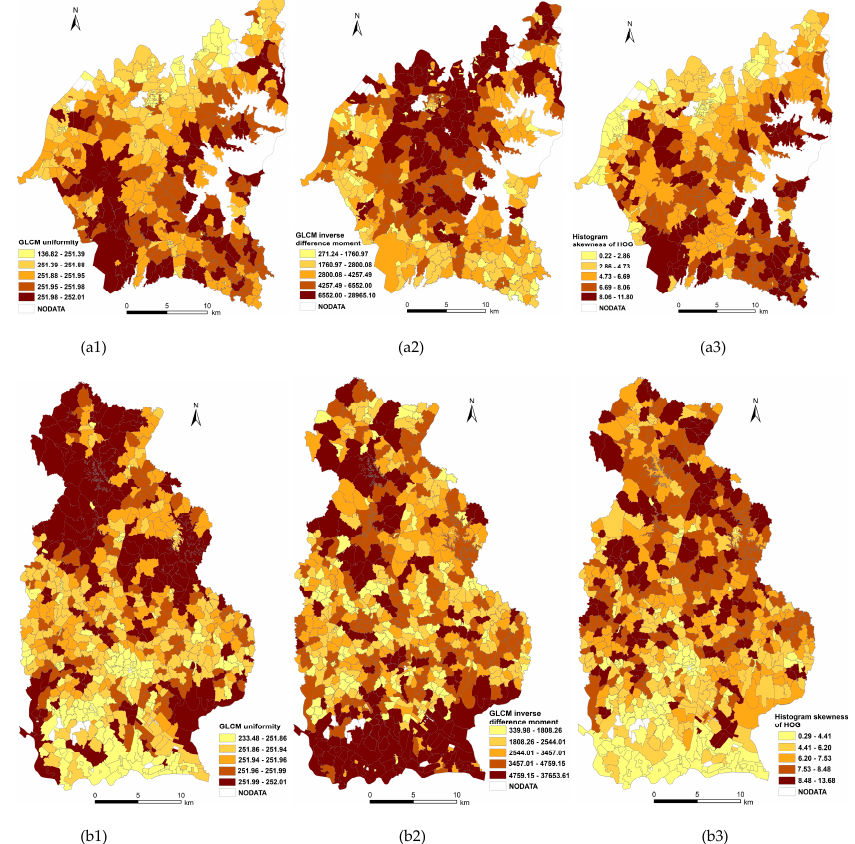
Figure 2. Selected feature examples showing the difference in feature of Jiangxia ( a1 – a3 ) and Huangpi ( b1 – b3 ) at the committee level.